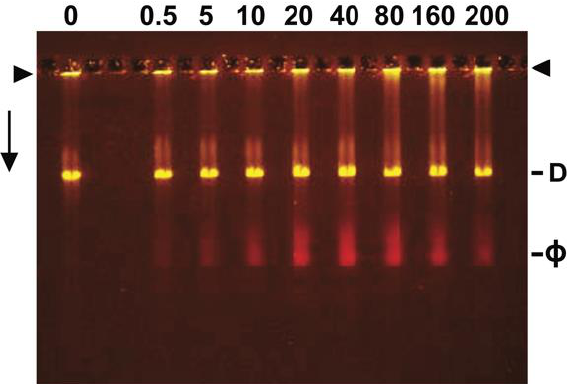
Figure 6. AGE of loading without the sucrose gradient. AGE for 17.0 h is shown after loading of phage T4 (0.29 µ g packaged DNA) performed at 55 ◦ C for 15 min at the ethidium concentration ( µ g/mL) indicated at the top of a lane. The arrow indicates the direction of electrophoresis. The arrowheads indicate the origins of electrophoresis. Fluorescence was imaged with the yellow emission filter.